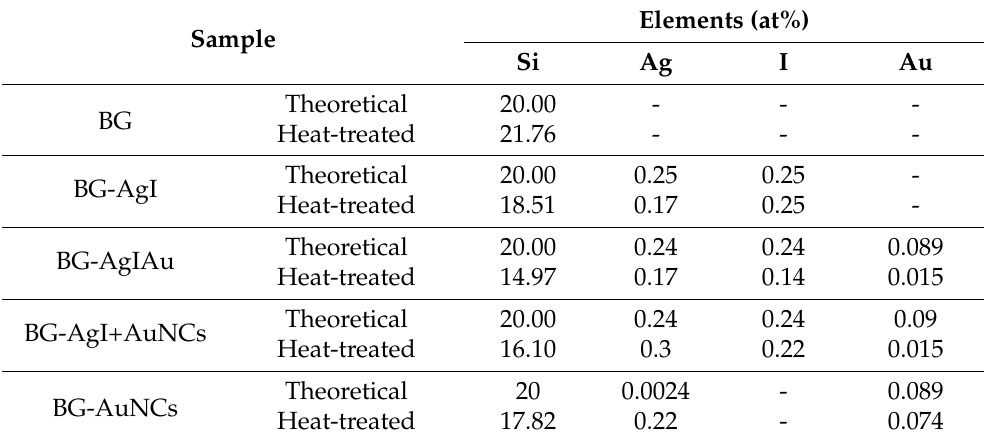
0.0 Figure 3. EDX spectra of the BG, BG-AgI, BG-AgIAu, BG-AgI+AuNCs, and BG-AuNCs samples. Table 2. Si, Ag, I, and Au content of the heat-treated BG composites obtained from EDX measurements. For comparison, theoretical values were also calculated.